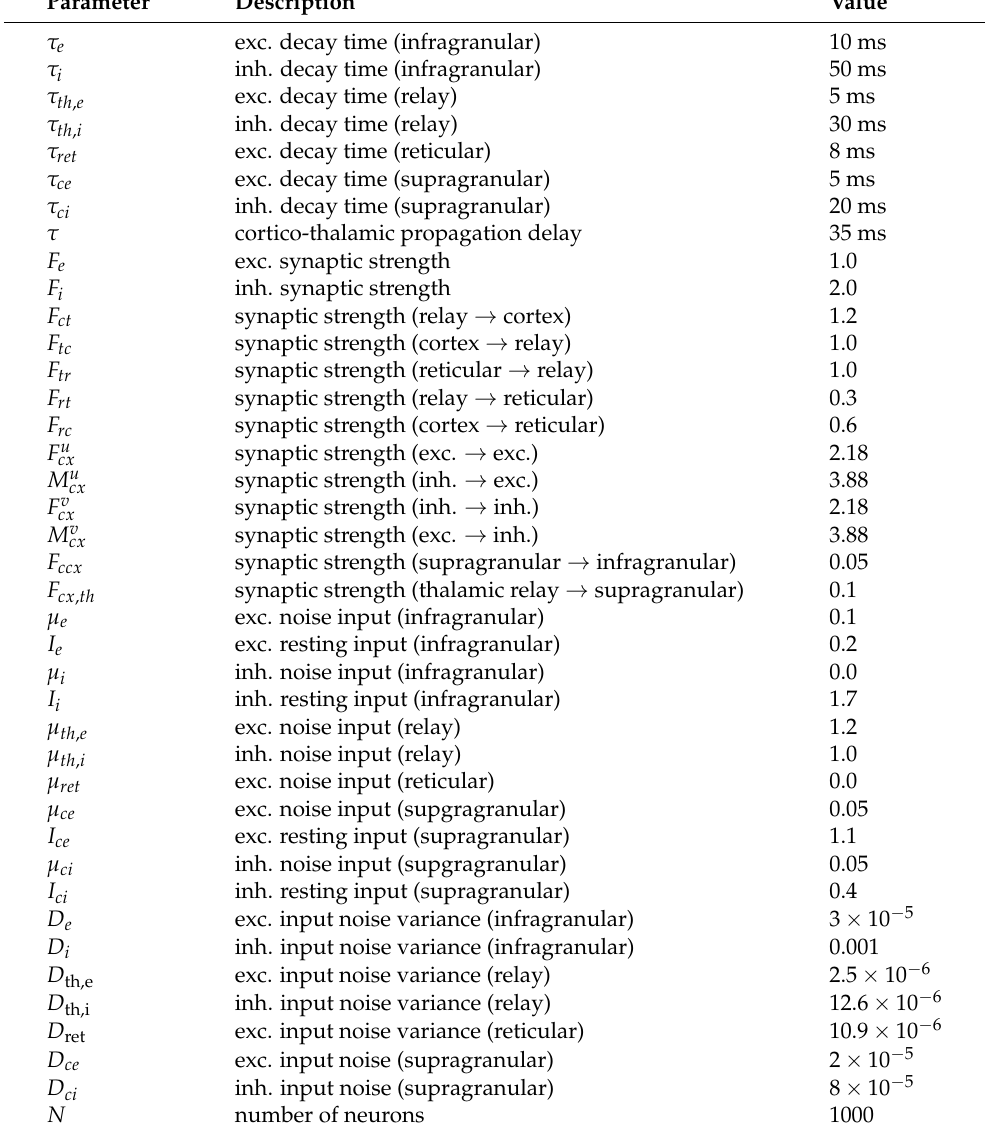
Table A1. Parameter set of model